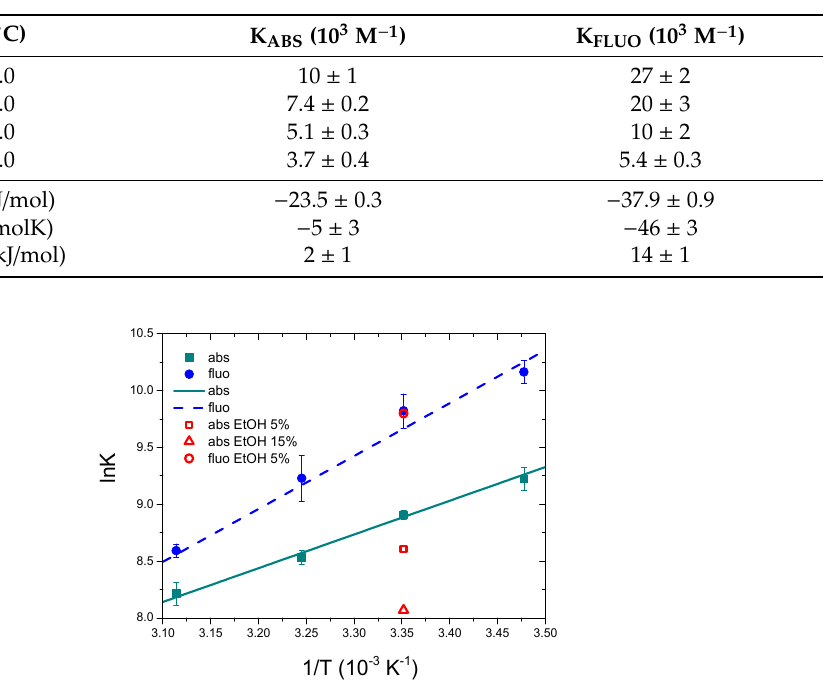
Table 1. Equilibrium constant (K) at different temperatures and thermodynamic parameters obtained from spectrophotometric and spectrofluorimetric titrations for the [Ag(EIA) 2 ] + /CT-DNA system; NaCl 0.1 M, NaCac 2.5 mM, pH = 7.0.